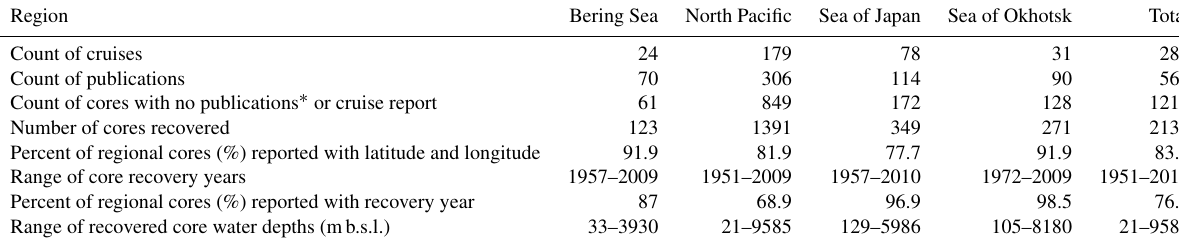
Table 1. Regional summary of sediment core database for the Bering Sea, North Pacific, Sea of Japan, and Sea of Okhotsk, including number of cores recovered, the regional percent (%) of cores reported with latitude and longitude, number of research cruises, total regional publication count, count of cores with no peer-reviewed publications or cruise report, the range of core recovery years, the regional percent (%) of cores reported with recovery years, and the range of recovered core water depths (mb.s.l.). Region